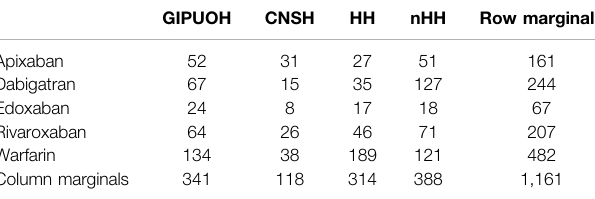
TABLE 2 | Frequency of observed AEs by drug, clustered into four MedDRA SMQs (GIPUOH, GastroIntestinal Perforation, Ulceration, Obstruction